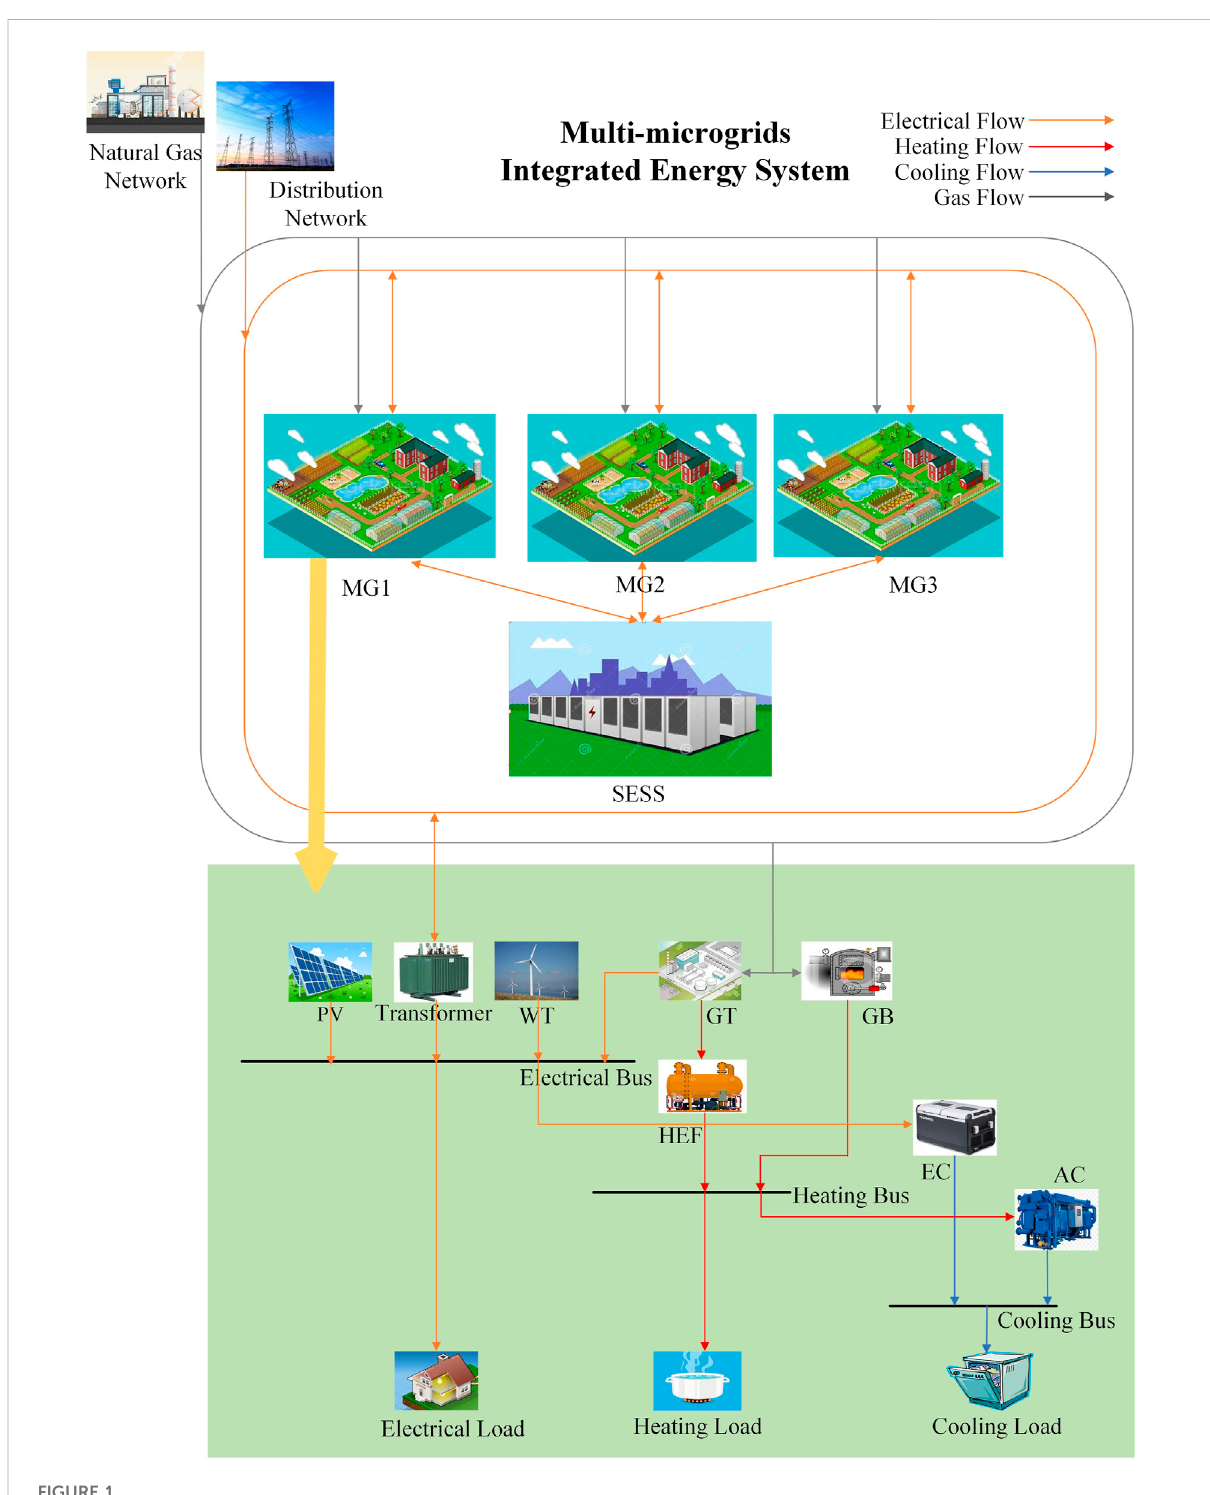
FIGURE 1 Architecture of the MMG-integrated energy